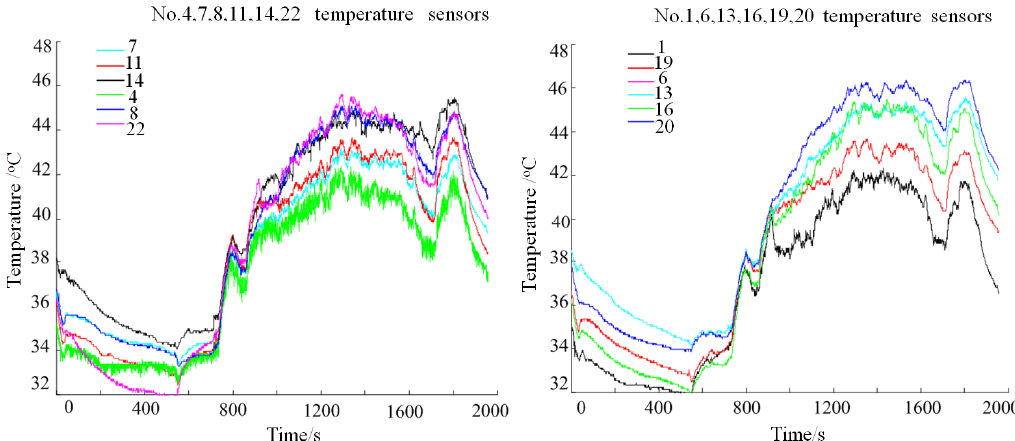
Figure 18. Temperature measurement in the climbing